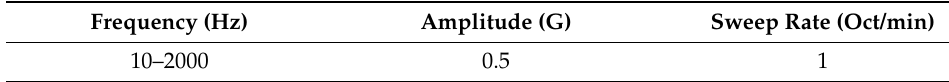
Figure 20. Vibration test sequence. Table 16. Low-level sine sweep test profile [3].